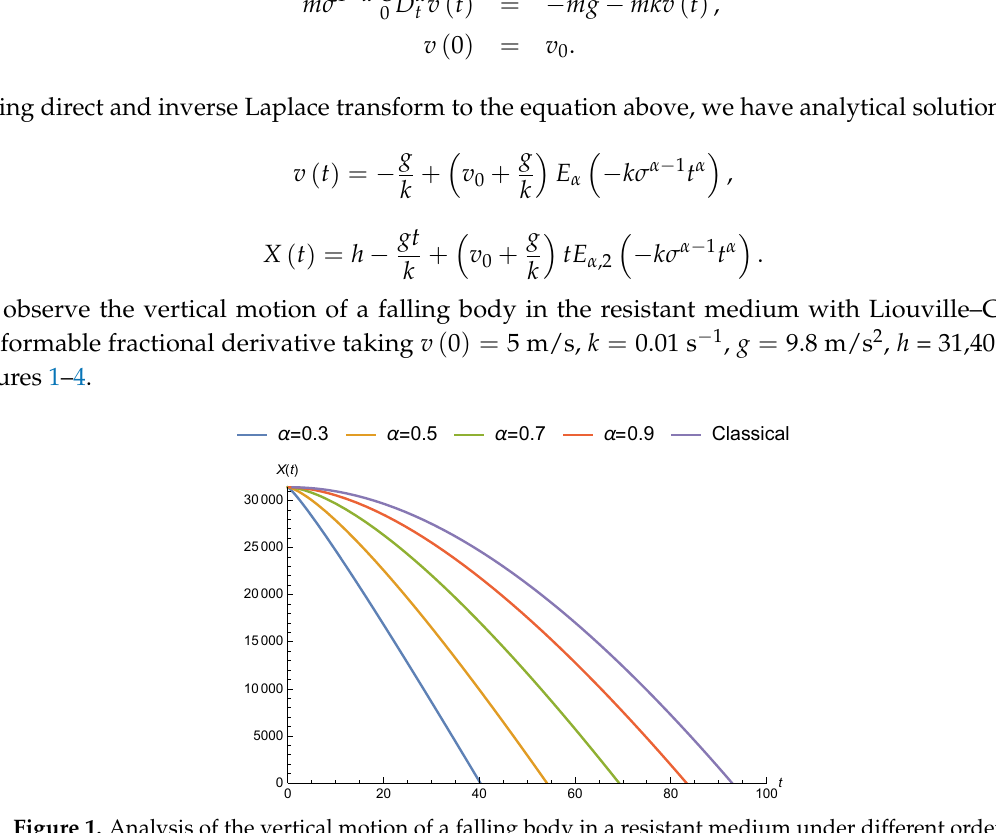
Figure 1. Analysis of the vertical motion of a falling body in a resistant medium under different orders while β = 0.9.